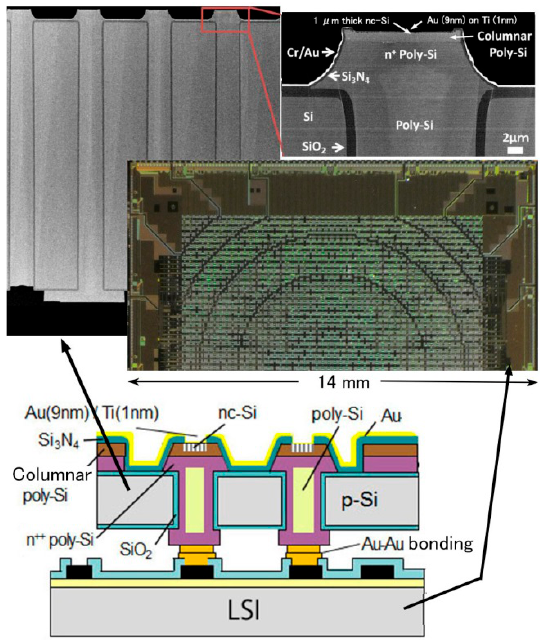
Figure 14. Structure of planer-type active matrix electron source using the nc-Si electron emitter.